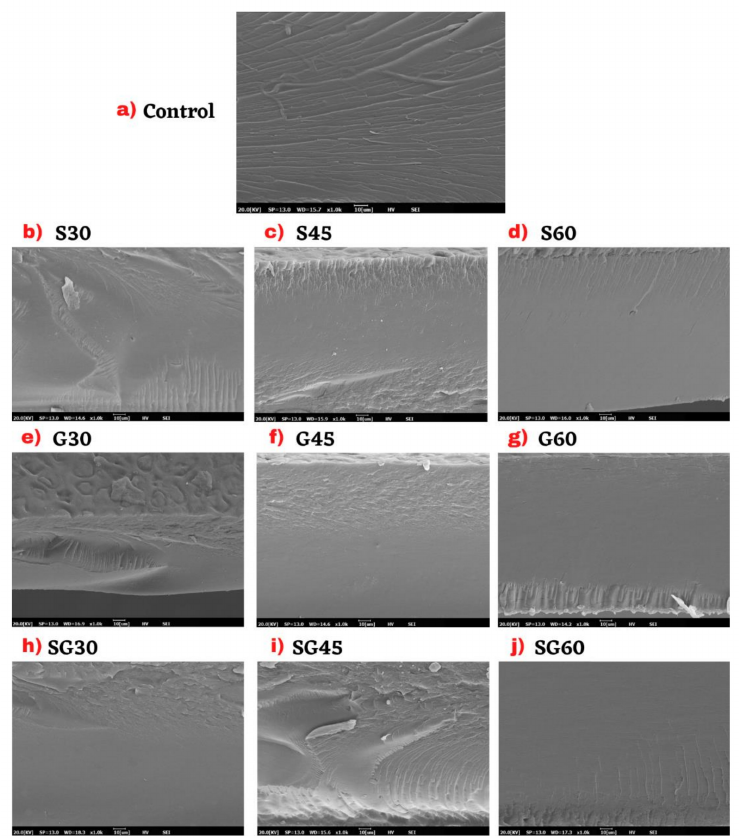
Figure 14. Scanning electron micrograph of CS films with various plasticizer and